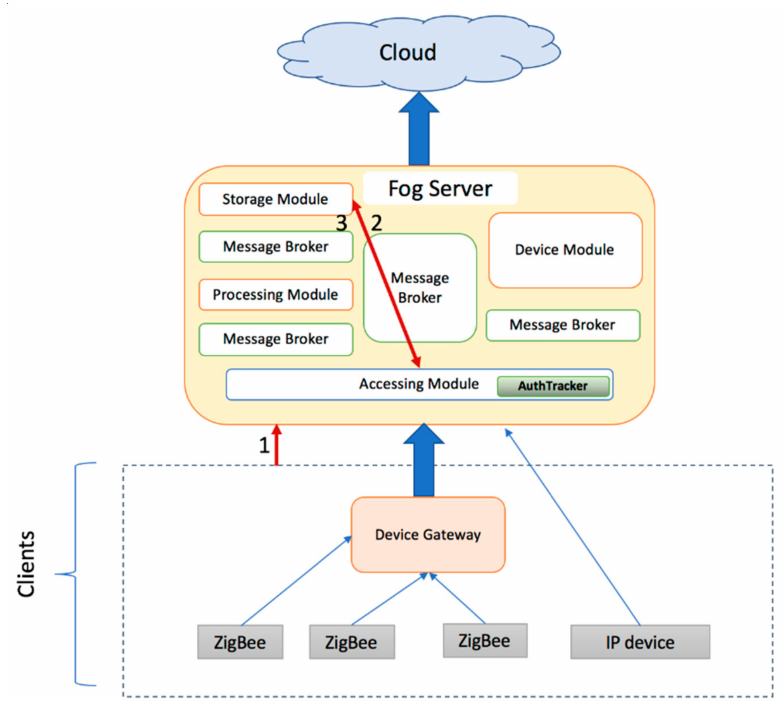
Figure 8. Data query workflow.